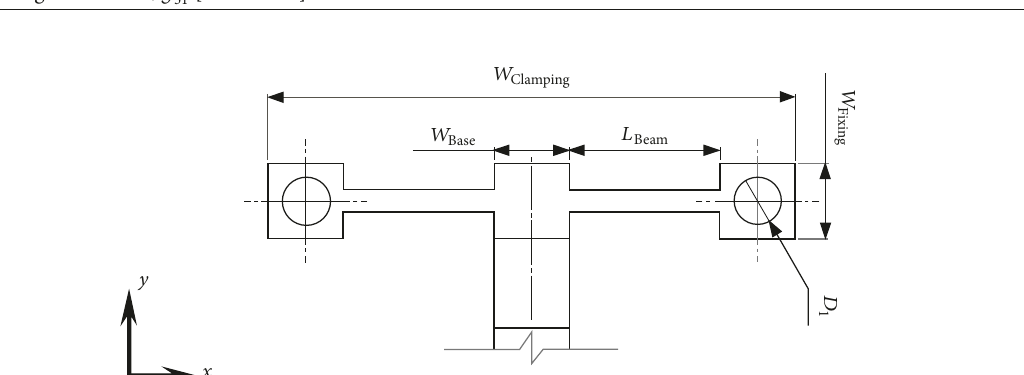
—35 mm; 𝑊 —5 mm; 𝐿 —10mm; 𝑊 —10mm; 𝐷 1 —3.2 mm. Clamping Base Beam Fixing